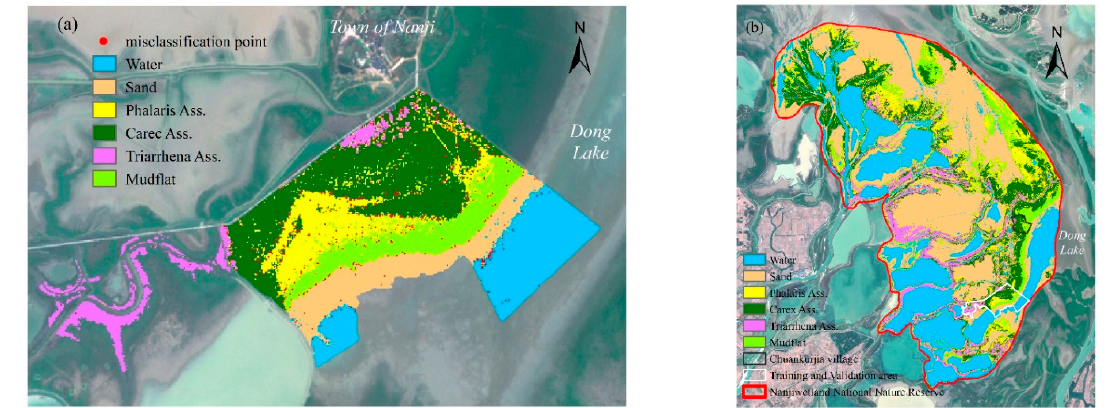
Figure 3. ( a ) Model simulation results of wetland plant community distribution and misclassifica- tion point distribution. ( b ) Classification of the wetland plant communities’ distribution in the whole NWNNR